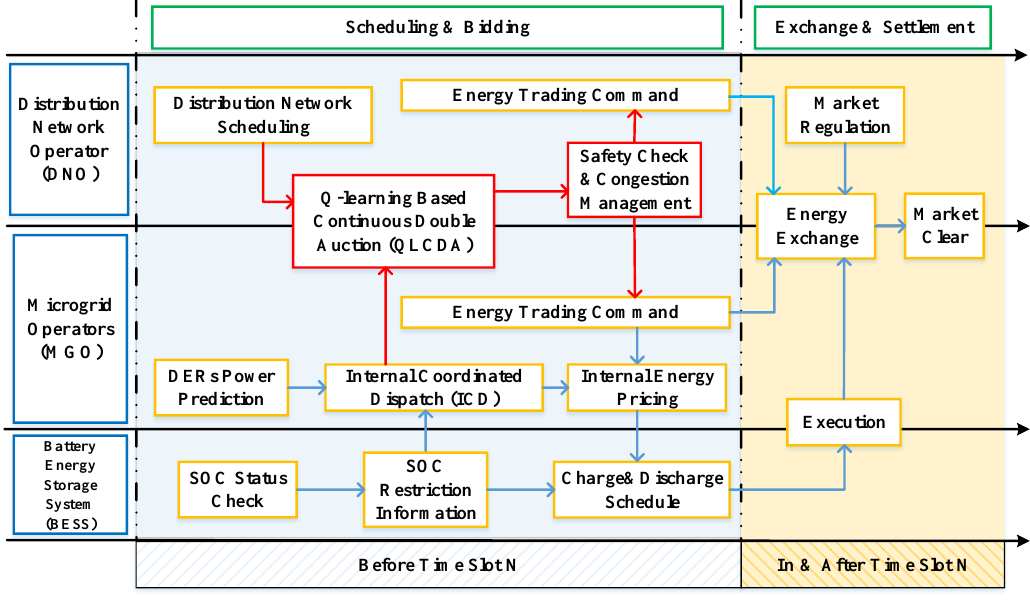
Figure 1. The process of the proposed non-cooperative energy trading